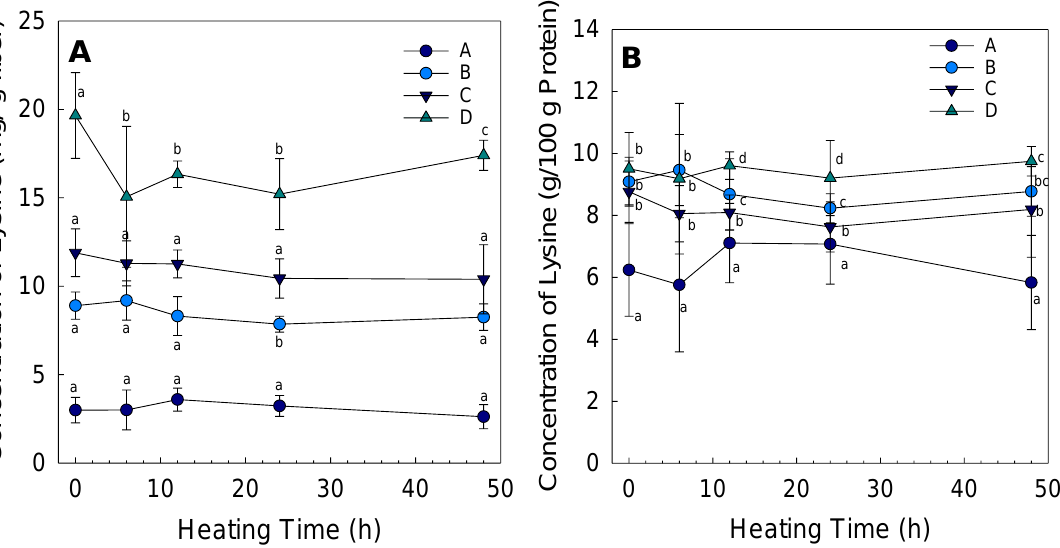
Figure 1. ( A ) Average concentration of lysine (mg/g fiber) and ( B ) concentration of lysine in the protein content over heating times for the different ratios (MD DE 2:MD DE 21:PP)(A (80:10:5), B (80:10:10), C (80:10:15), and D (80:10:20)) with standard deviation (different letters indicate significant differences ( A ) between heating times at the same blend and ( B ) between blends at the same heating time ( p < 0.05)). Table 1. Browning indexes at different heating times, diameters of the fibers, and protein ratios between mixture and fibers (different letters indicate significant differences between heating times in the same blend (lower case) and between blends at the same heating time (upper case) ( p < 0.05)). Blend Heating Time Browning Index (-) Diameter ( µ m)